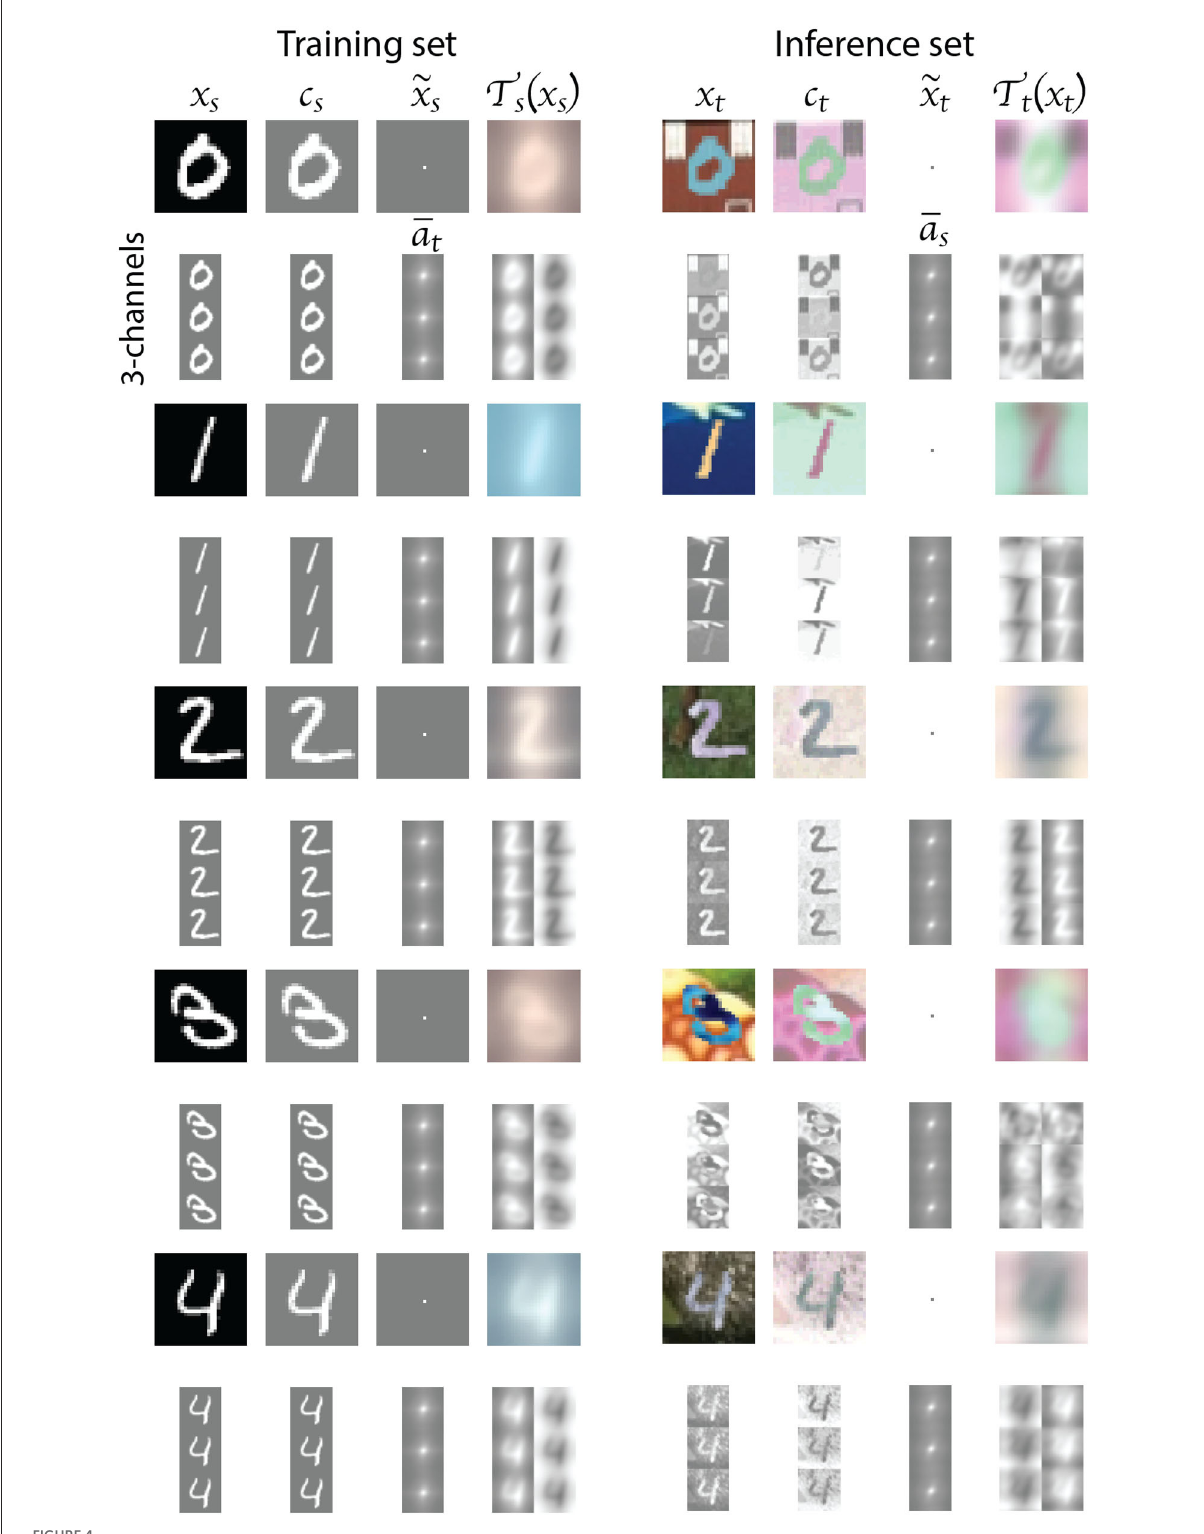
FIGURE4 The transformation results for examples from digits 0 to 4 images. The left column shows the transformation of source (MNIST) data, and the right column shows the transformation of the target (MNIST-M) data. For each input, we show the composite and the 3-channel transformation. The last column of the second row shows the 3-channel output and its polarity reversal, which we implement in the augmentation of the training